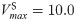
Model of plant iron homeostasis integrating uptake, storage, assimilation/transport and remobilization from the store.(a) The model combines a low-affinity iron uptake based on an iron-dependent derepression mechanism of inhibitor S [53], which leads to iron storage (outlined in blue), an R-based iron remobilization mechanism from the store (outlined in ochre), the FIT-based high-affinity iron uptake mechanism from Fig 5a (outlined in green) and a lumped expression for the iron assimilation and transport flux to other parts of the plant (outlined in red). Note the renumbering for some of the rate constants in comparison with Fig 5a. See S4 Text for rate equations. (b) Calculation showing cytosolic and external iron concentrations during the low- and high-affinity uptake of iron and iron remobilization from the vacuole. (c) Same calculation as in (b), but showing the different iron fluxes. Rate constants and initial concentrations for (b) and (c): k1 = 1.0, k2 = 2.0, k3 = 1 × 102, k4 = 1.0, k6 = 4 × 102, k7 = 1 × 102, k8 = 1 × 102, k9 = 15.0, VmaxS=10.0, KMS=1×10-4, KIS=0.1, k13 = 0.5, k14 = 0.8, VmaxR=1.0, KMR=1×10-6, k19 = 0.5, k22 = 5 × 10−4, KIFe=1.0, k24 = 4.0, VmaxFIT=2.0, KMFIT=1×10-4, k27 = 1 × 103, k28 = 1 × 103, k29 = 1 × 104; k30 = 2 × 104, k32 = 1 × 102, k33 = 10.0, KaFIT·TF=1×104, KIFIT=0.01. Feext,0 = 10.0, all other initial concentrations are zero.